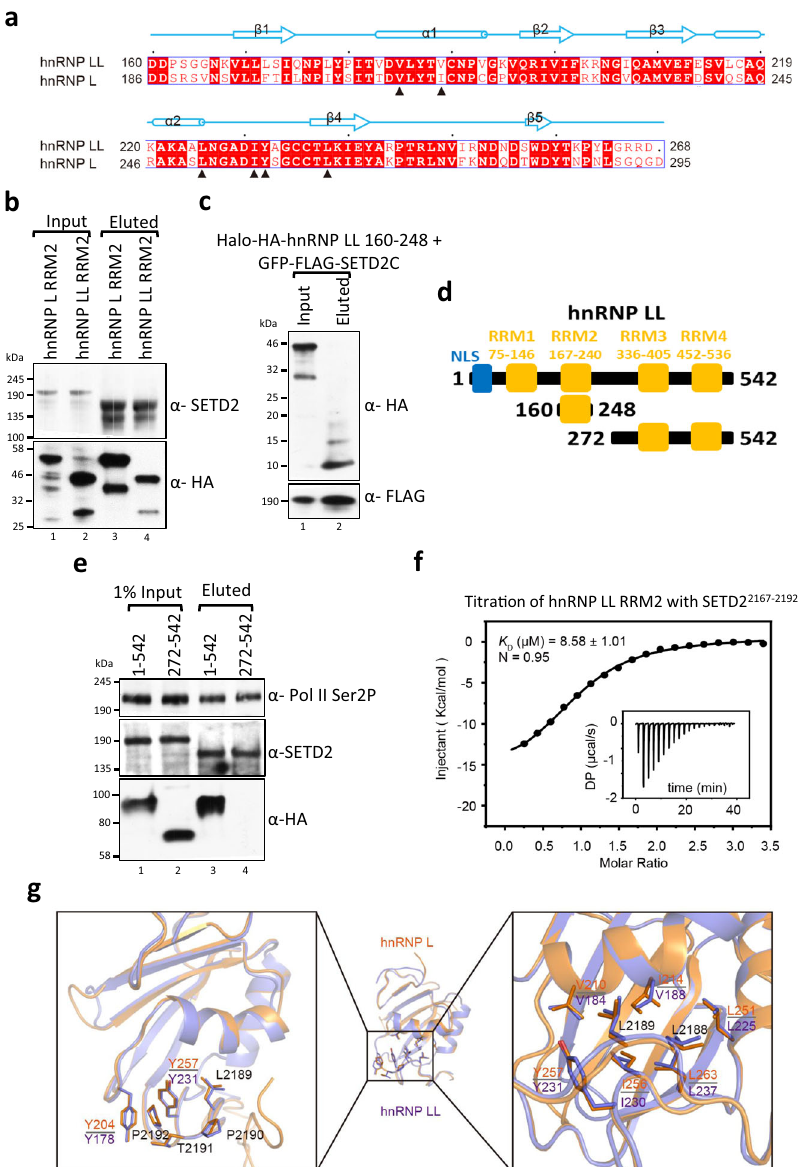
Fig. 4 hnRNP LL RRM2 – SETD2 interaction occurs in a similar fashion as hnRNP L – SETD2 binding. a Sequence alignment of hnRNP L RRM2 and hnRNP LL RRM2 proteins. The alignment was generated by ESPript3 79 with CLUSTALW80 . The secondary structures of hnRNP L RRM2, as determined by DSSP, are shown above the sequences. Red squares denote identical residues whereas black triangles highlight the key residues involved in the interaction with SETD2. b , e Halo puri fi cation was performed from extracts of 293 T cells co-expressing Halo-tagged SETD2C and mCherry-HA-hnRNP L/LL constructs. Input and eluted samples were resolved on gel followed by western blotting. The experiment was repeated at least 2 times all yielding similar results. Source data are provided as a Source Data fi le. c Halo puri fi cation was performed from extracts of 293 T cells co-expressing Halo-HA-tagged hnRNP LL and GFP-FLAG-SETD2C constructs. Input and eluted samples were resolved on gel followed by western blotting. The experiment was repeated at least two times all yielding similar results. Source data are provided as a Source Data fi le. d Schematic representation of hnRNP LL segments used in puri fi cation experiments. f ITC titration data of hnRNP LL with SETD2 2167 – 2192 and its fi tting curve are shown. For the arithmetic mean of K D values of the three independent experiments and the thermodynamic parameters see Supplementary Table 1. All ITC binding curves are shown in Supplementary Table 2. g (Left) Structure comparison of hnRNP L_RRM2 – SETD2 2167 – 2192 complex (orange) and hnRNP LL_RRM2 – SETD2 2167 – 2192 complex (purple). (Right) Two complexes are shown as ribbons with selected sidechains as sticks. K D dissociation constant, DP differential power, N binding stoichiometry. RRM – RNA recognition motif, NLS nuclear localization antibody con fi rmed the co-puri fi cation of ectopically expressed WT hnRNP L FL and the lack of SETD2 binding to hnRNP L L RRMs. The residues V210, I214, L251, I256, Y257, L263 of 322 – 589 as we have previously shown 23 (Fig. 5b). Importantly, the hnRNP L FL mutant in which both I256 and Y257 were mutated to alanine did not interact with SETD2, con fi rming our ITC data (Fig. 5b).